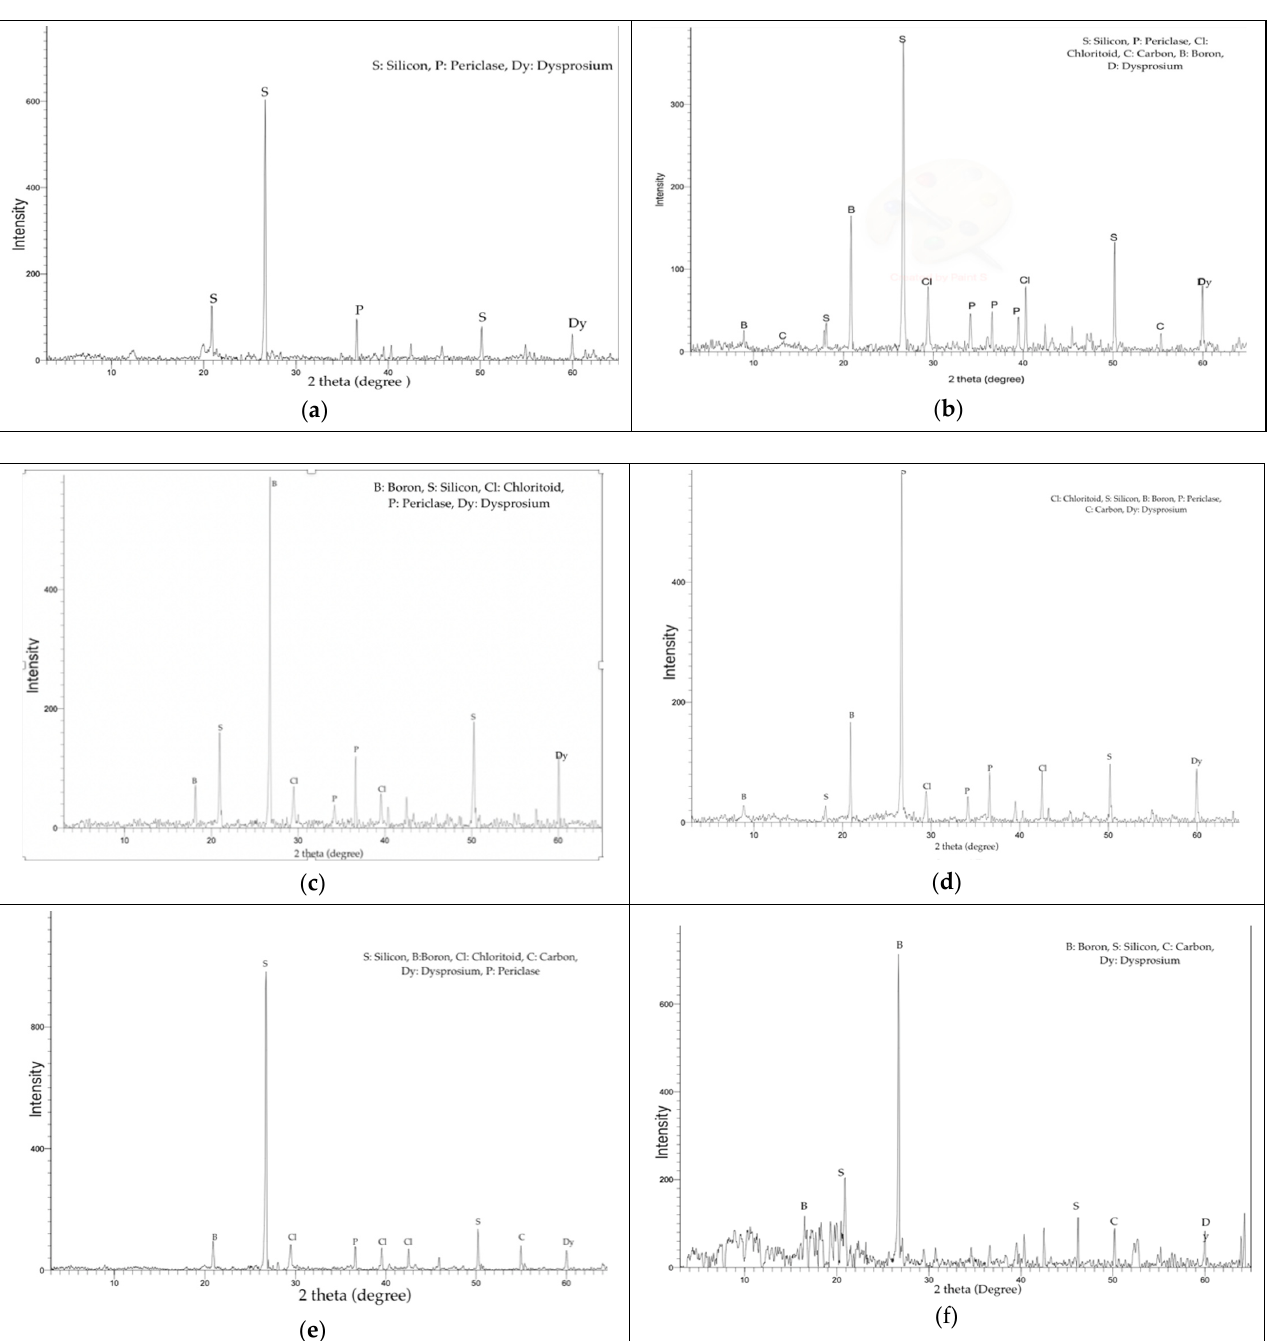
Figure 4. XRD spectra of: ( a ) unstabilised termite mound soil; ( b ) Ordinary Portland Cement; ( c ) specimens containing 5 wt% of stabilisation; ( d ) specimens containing 10 wt% of stabilisation; ( e ) specimens containing 15 wt% of stabilisation; ( f ) specimens containing 20 wt% of stabilisation.